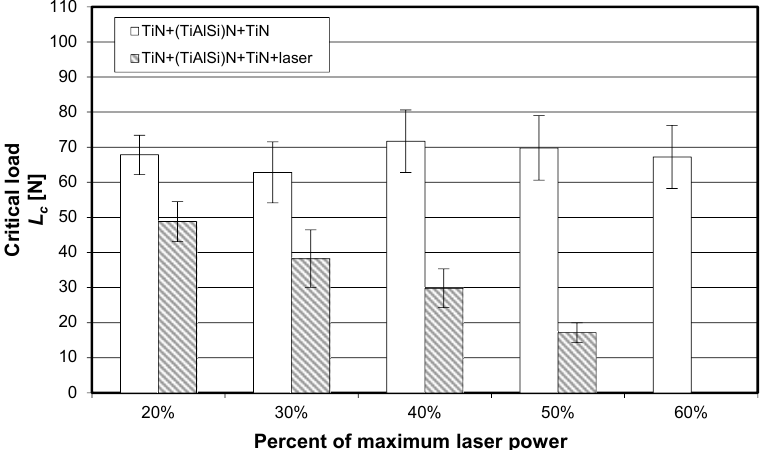
Figure 8. Impact of laser heating on the adhesion (critical load determined by scratch test) of the triple-layer coating (TiN + (TiAlSi)N + TiN) to the SM25 sintered carbide cutting inserts (P15–P40).